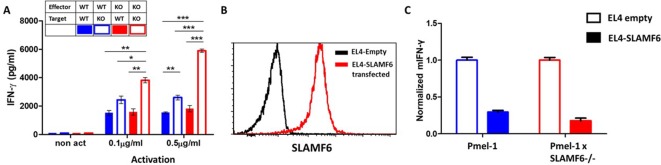
The contribution of cis and trans SLAMF6 interactions to CD8+ T cell function.(A) Separated CD8+ splenocytes from Pmel-1 and Pmel-1 x SLAMF6 -/- were co-cultured (1 × 105) overnight at the indicated ratios with non-T splenocytes from both mice splenocytes. IFN-γ secretion was measured by ELISA. (B) SLAMF6 expression on EL4 parental or transfected (SLAMF6 or empty) cells. (C) Pmel-1 or Pmel-1 x SLAMF6 -/- splenocytes were activated for 7 days with gp10025-33 peptide and IL-2 (30 IU/ml) and then incubated overnight with gp10025-33 pulsed EL4 cells (empty or SLAMF6 transfected), at a 1:1 effector-to-target ratio. IFN-γ secretion was measured by ELISA. IFN-γ values are normalized to the results of EL4-empty for each mouse splenocytes. One-way ANOVA test. *, p<0.05, **, p<0.01, ***, p<0.001.